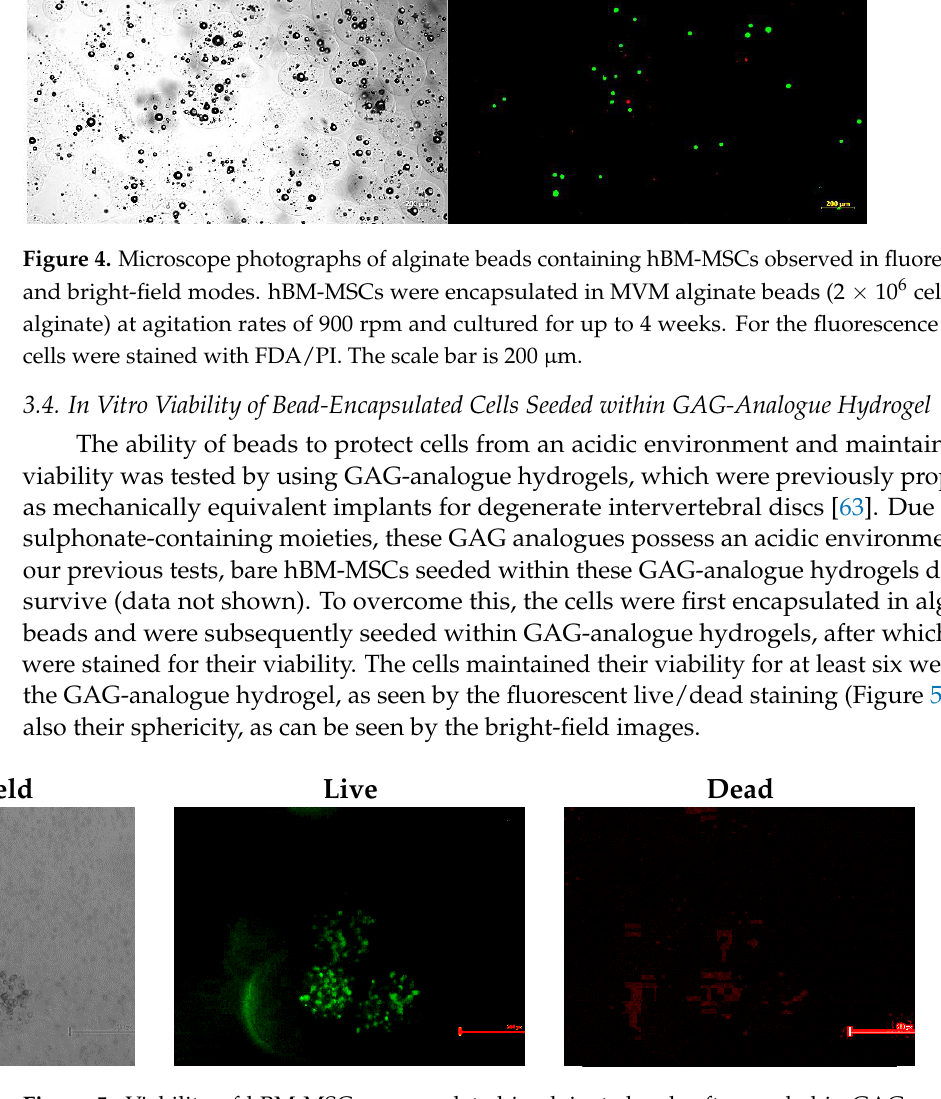
Figure 5. Viability of hBM-MSCs encapsulated in alginate beads after seeded in GAG-analogue hydrogel. Constructs comprising GAG analogue (1.5%) and encapsulated cells (2 × 10 6 cells/mL beads) were incubated for six weeks and stained with a LIVE/DEAD ® assay kit. hBM-MSC-loaded beads were imaged using bright-field and fluorescence microscopy. The scale bar is 200 µm.